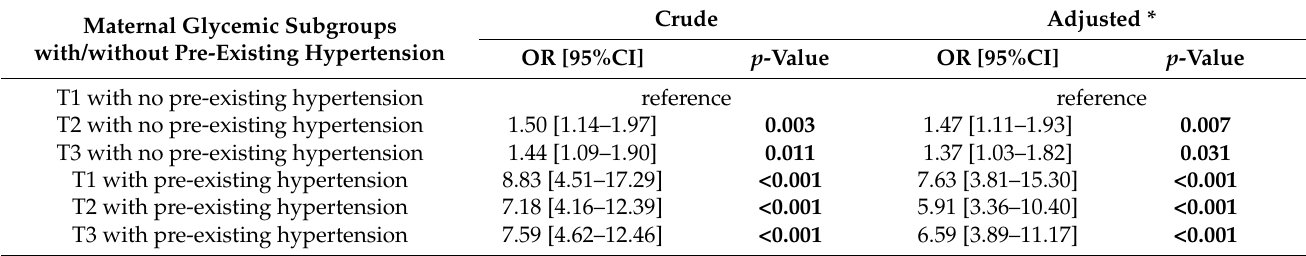
Figure 1. Adjusted Odds Ratios and 95% Confidence Intervals Showing Association of Maternal Glycemic Spectrum with Hypertensive Disorders of Pregnancy and Preterm Birth. ( a ) Adjusted Odds Ratios and 95% Confidence Intervals Showing Association of Maternal Glycemic Spectrum with Hypertensive Disorders of Pregnancy; ( b ). Adjusted Odds Ratios and 95% Confidence Intervals Showing Association of Maternal Glycemic Spectrum with Preterm Birth. Table 2. Crude and Adjusted Odds Ratios with 95% Confidence Intervals for the Association of Maternal Glycemic Subgroups (with/without Pre-existing Hypertension) with Hypertensive Disorders of Pregnancy † .